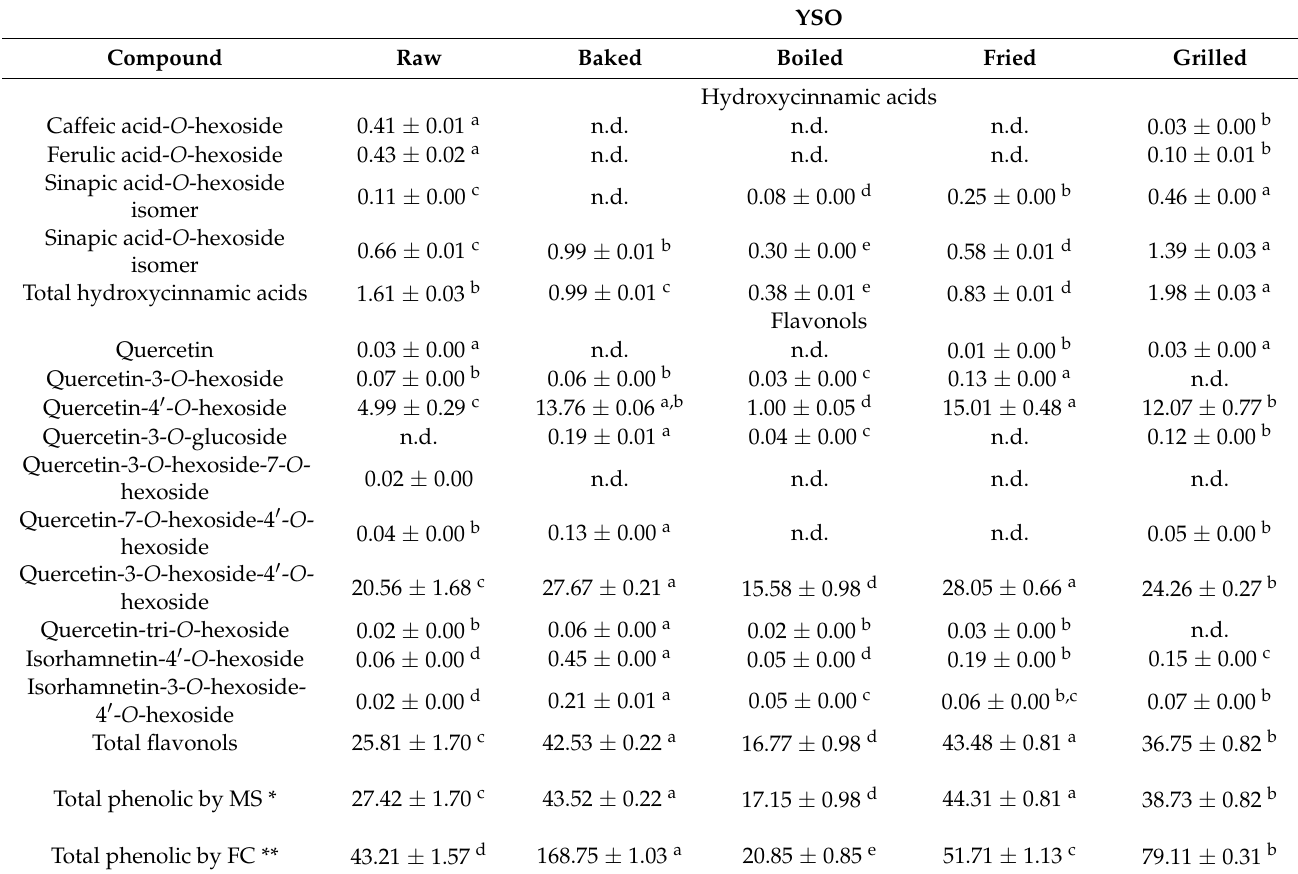
Table 2. Amount of phenolic compounds in raw and cooked yellow-skinned onion (YSO). Results are expressed in mg of phenolic compound/100 g of raw or cooked onion. YSO Compound Raw Baked